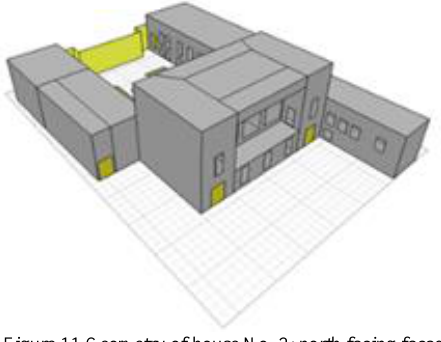
Figure 11 Geometry of house No. 2; north facing façade